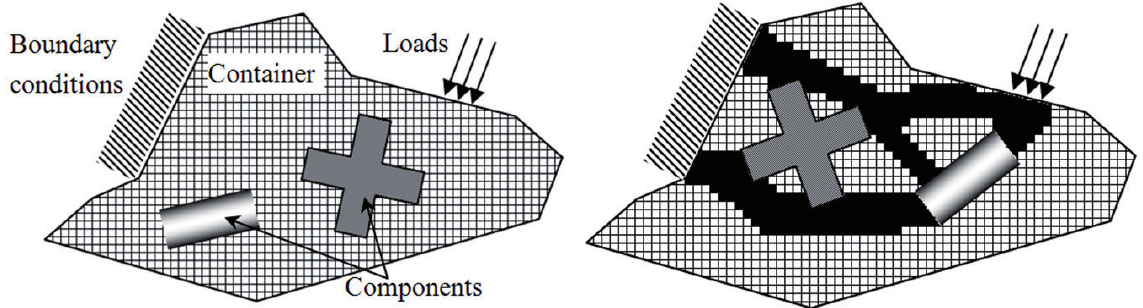
Fig. 1. An illustrative multi-component design